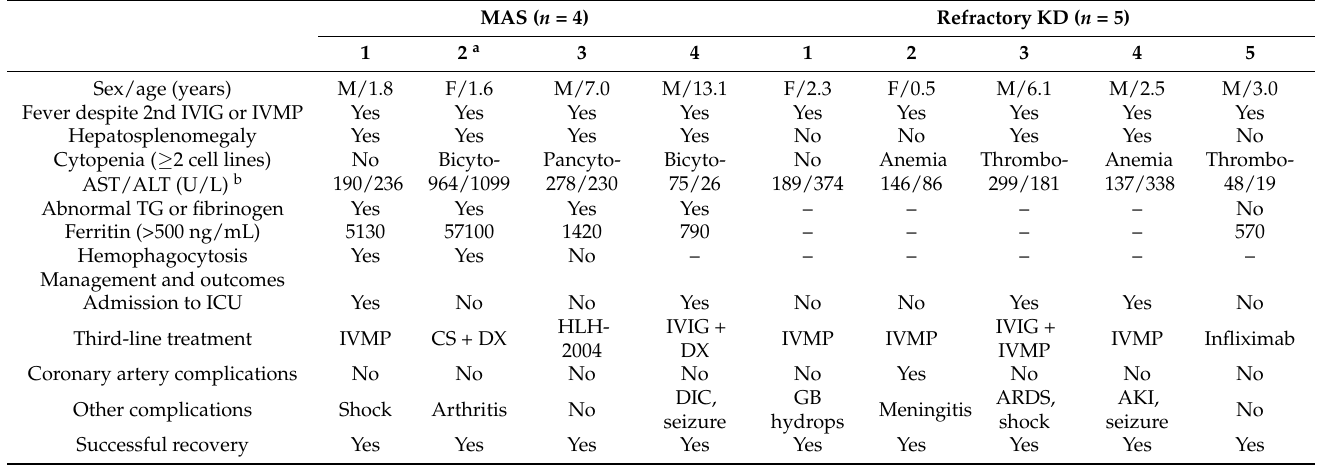
Table 2. Clinical and laboratory characteristics of patients who received third-line treatment.